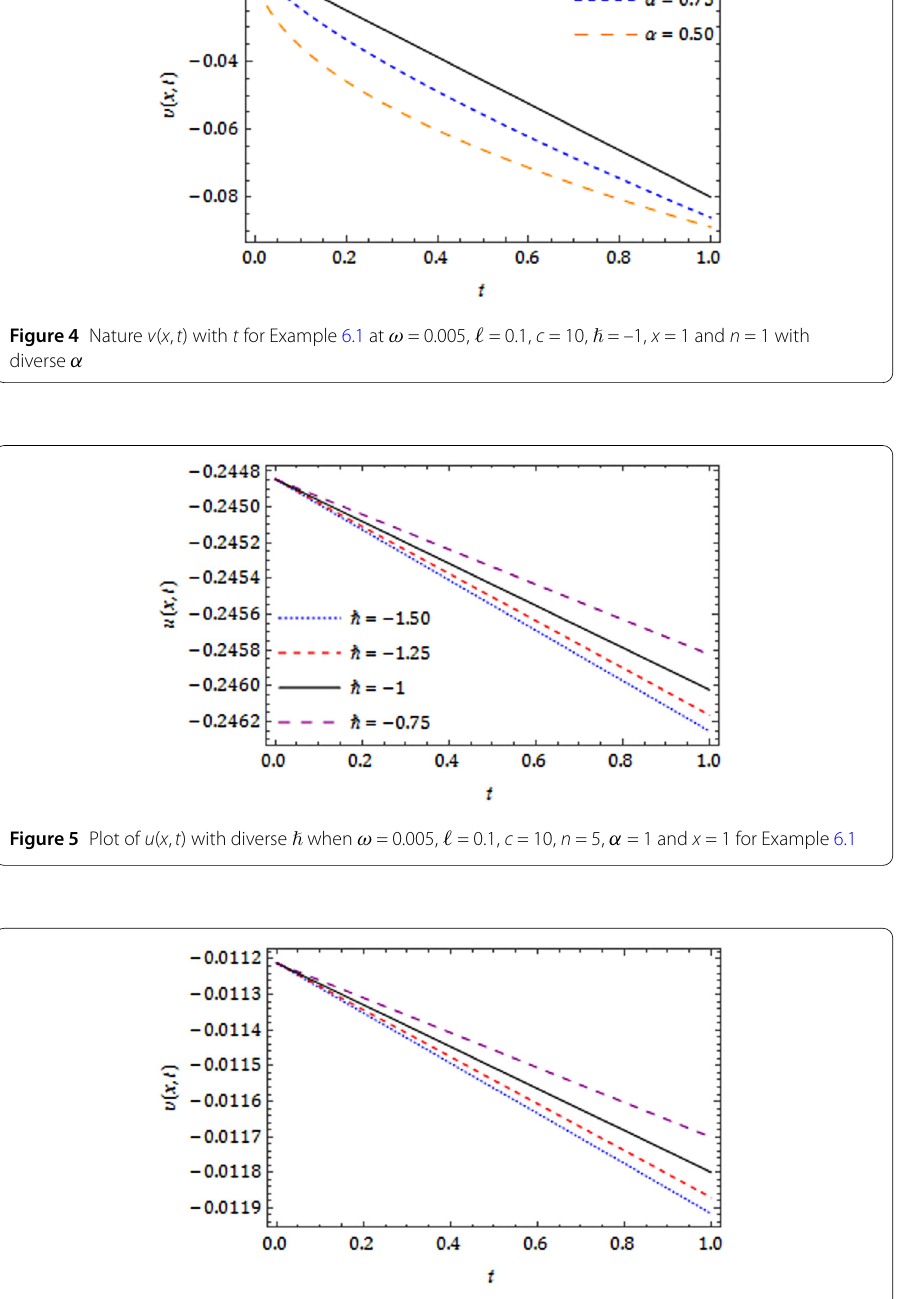
solution for distinct α i.e. α = 1,0.75 and 0.50. Figures 14 and 15 cite the nature of ob- tained solutions for distinct (cid:2) , and these aid us to control the convergence region. Finally, Figs. 16–17 signify the (cid:2) -curves and the horizontal line illustrates the region of conver- gence for FALW equation. The coupled surface of the MB and ALW equations